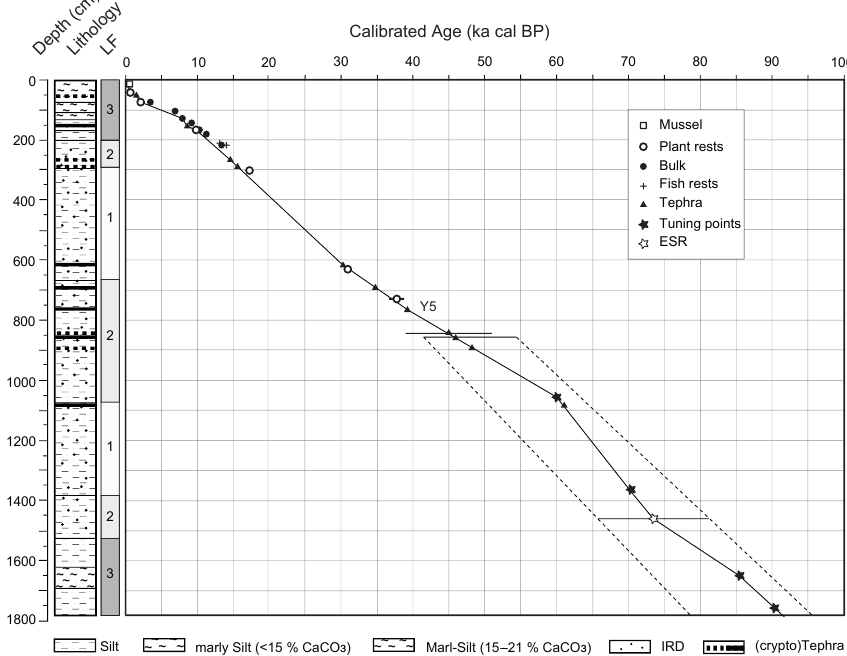
Fig. 3. Age model of core Co1215 with lithology. Reliable age control points were interpolated on a linear